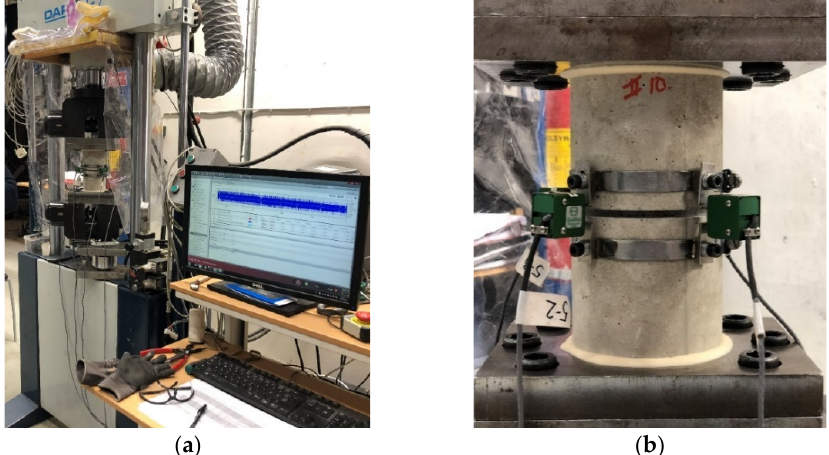
Figure 3. ( a ) Test setup with test rig to the left and computer station to the right. ( b ) Concrete cylinder mounted inside the test rig.